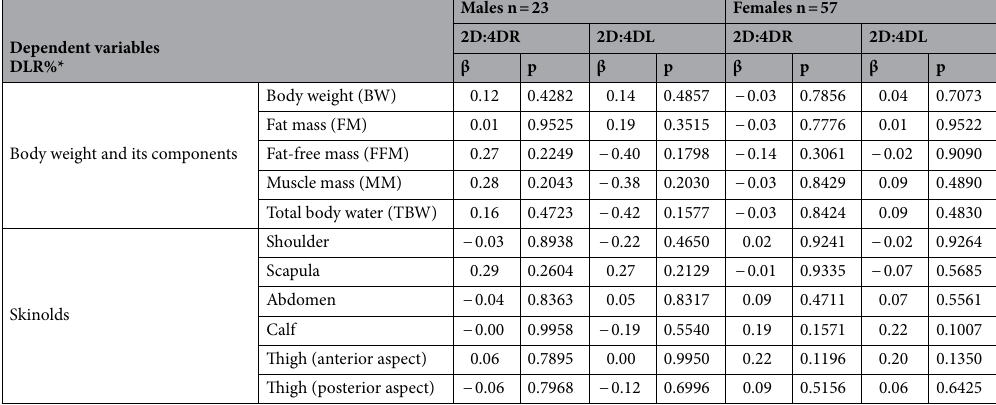
Table 5. Multiple regression analysis results concerning the relationship between the 2D:4D of the right and left hand and the rate of weight reduction and its components, as well as the thickness of the skin and fat folds. *DLR% adjusted for age after Box-Cox transformation and type of bariatric surgery. β, standardized regression coefficient; p, probability.